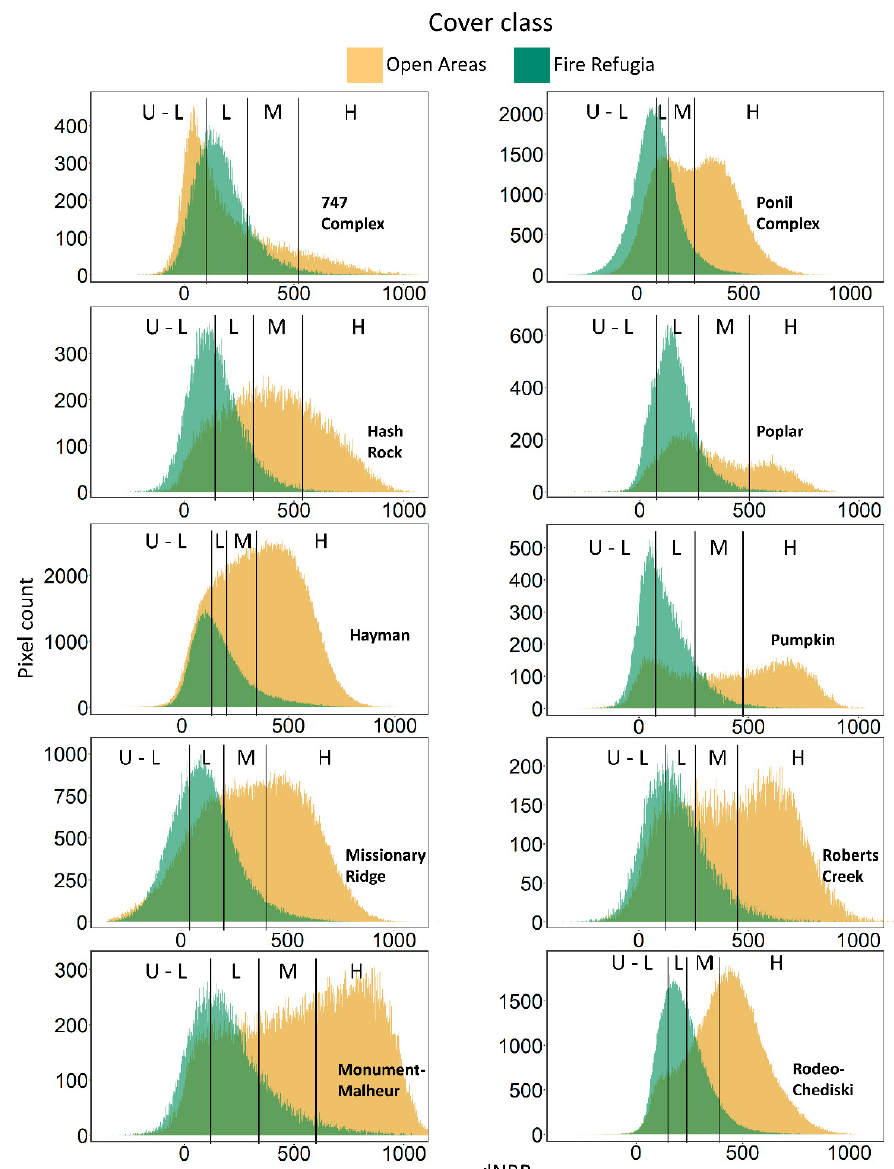
Figure 6. Distributions of dNBR values by cover class. Vertical lines indicate MTBS thresholds for unburned-low (U-L), low (L), moderate (M), and high (H) severity classes (threshold values vary by fire). Note: y-axis scale varies among burns. Table 4. Proportion of each MTBS dNBR burn severity class composed of fire refugia and open areas.